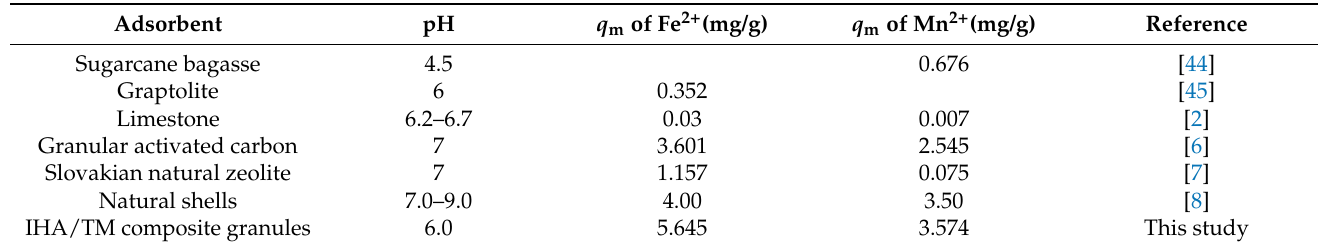
Table 5. Comparison of the IHA/TM composite adsorbent with previously reported adsorbents for the removal of iron and manganese in terms of uptake capacity.